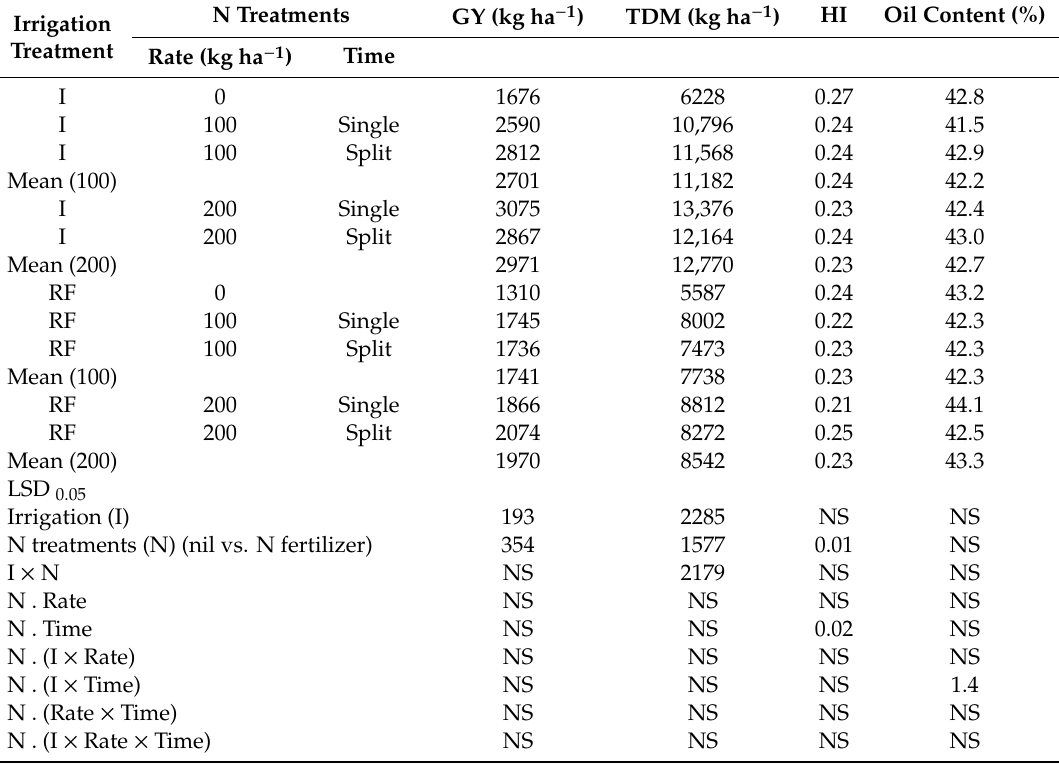
Table 2. E ff ect of di ff erent nitrogen (N) applications on seed yield, total dry matter (TDM), HI and oil content of canola under irrigated and rainfed conditions at Roseworthy